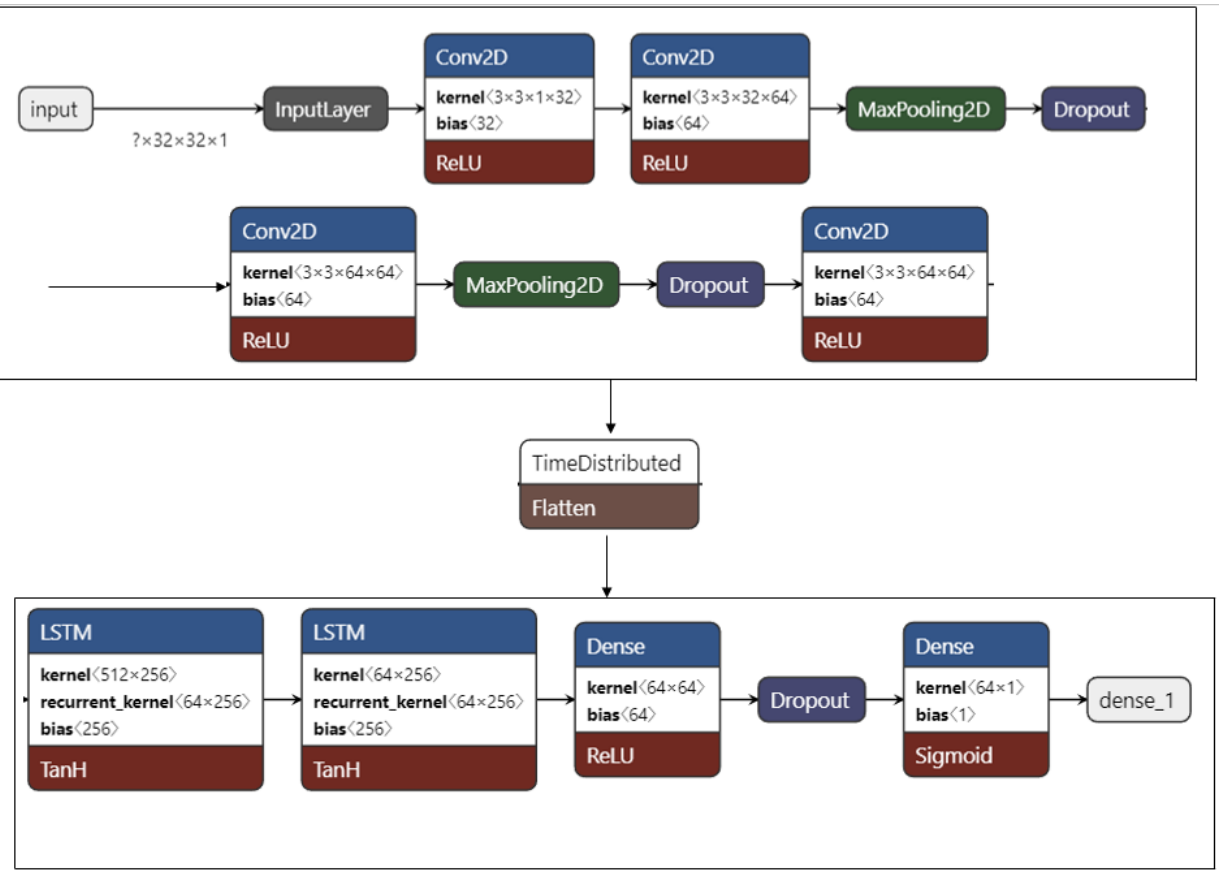
Figure 12. CNN–LSTM model architecture.